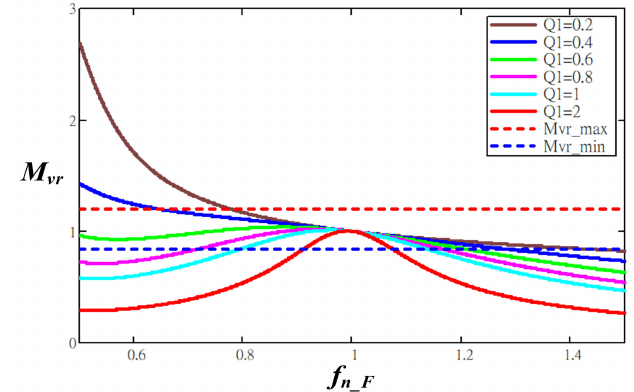
Figure 10. Voltage gain curves with di ff erent Q1 and fixed k 1 , g 1 , and m 1 .